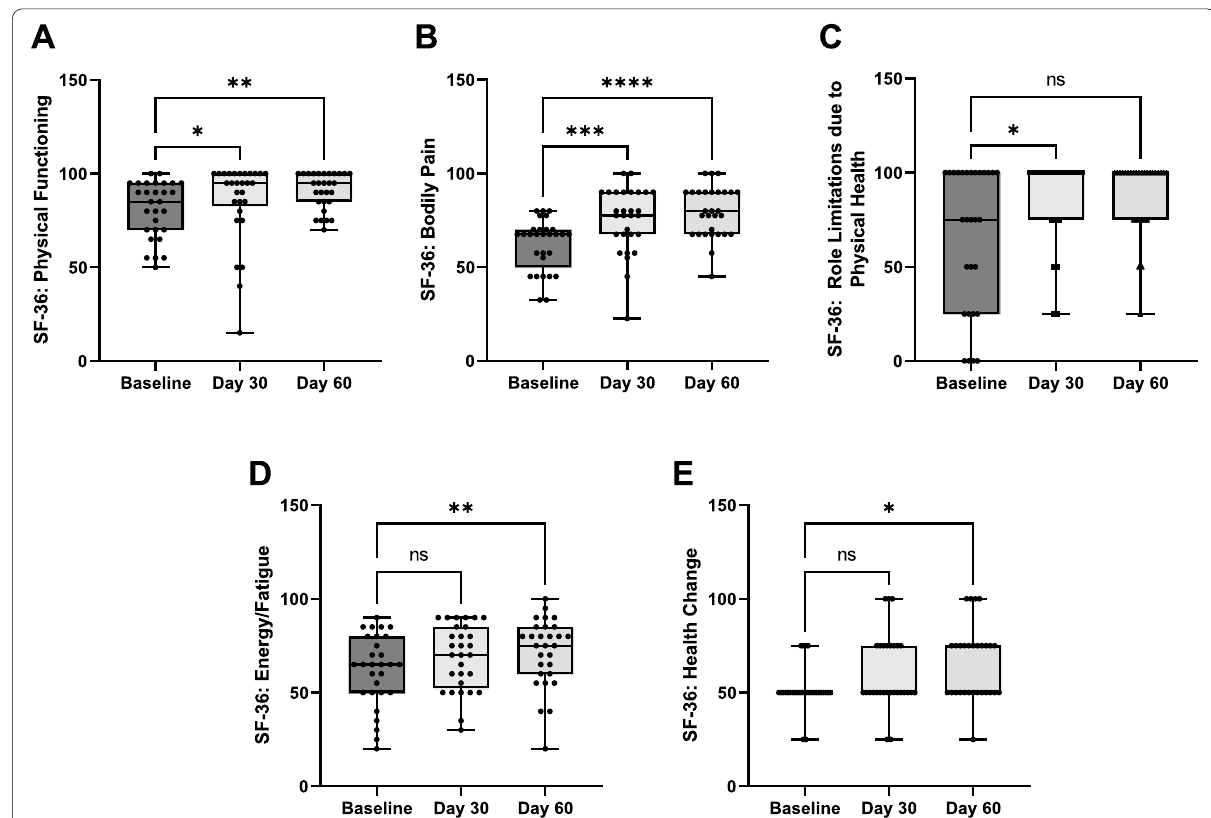
Fig. 3 Box and whisker plots of the SF‑36 Health Survey categories showing significant changes during the study: A Physical functioning, B Bodily pain, C Role limitations due to physical health, D Energy/fatigue and E Health change. Statistical analyses were performed using the non‑parametric Friedman test followed by the Dunn’s multiple comparison post‑hoc test to identify changes from baseline. The following denotes the level of statistical significance; ns p > 0.05, * p < 0.05, ** p < 0.01, *** p < 0.001, **** p < 0.0001 ( n =